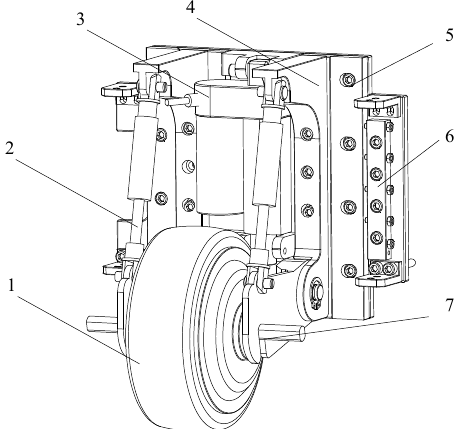
Figure 14. The structural design of the power-assisted moving part; 1—the power-assisted wheel; 2—the gas spring; 3—the push rod; 4—the support of the gas spring; 5—the pressure plate of the dovetail groove; 6—the adjust block of the dovetail groove; 7—the support of the power-assisted wheel.